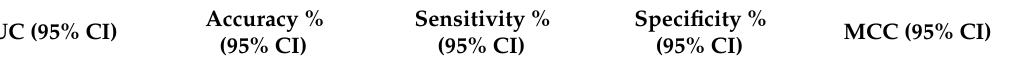
Table 2. Performance of different models and colposcopists for detecting